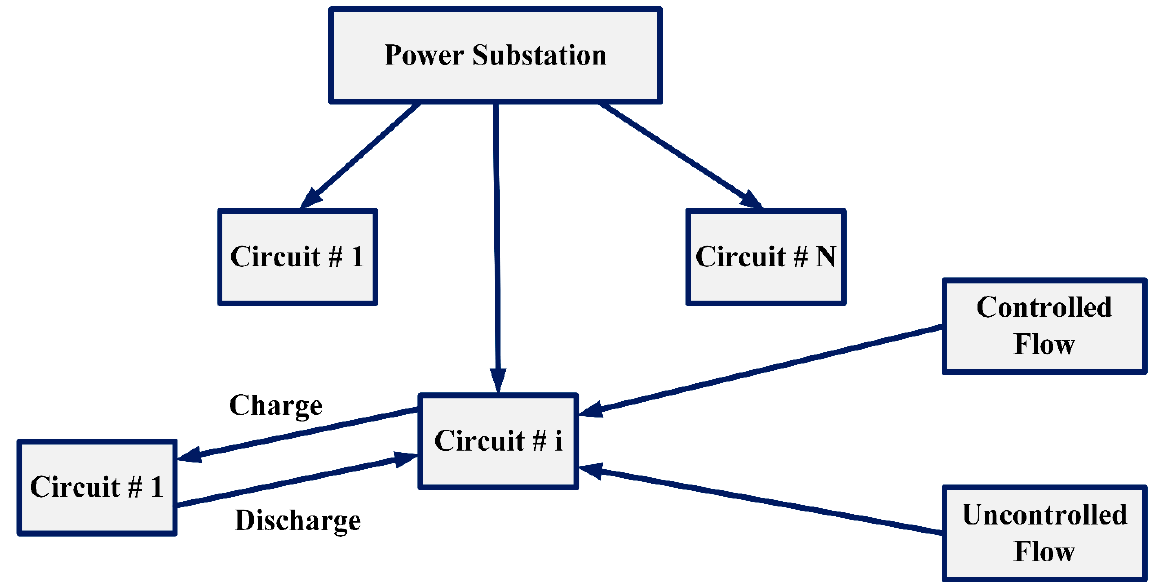
Figure 7. Effect of energy storage for controllable power flow.